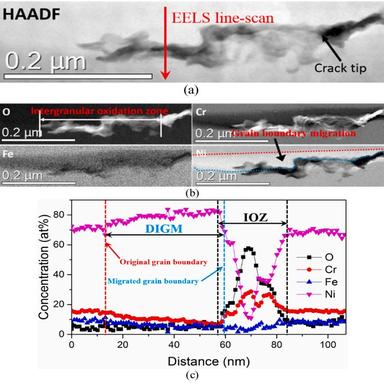
(a) HAADF image showing the morphology around a representative crack tip prepared from Fe-16Cr-75Ni alloy tested at 360 ◦C; (b) EELS elemental O K edge and Cr/Fe/Ni L edge maps; (c) EELS quantitative composition line profiles across the IOZ and DIGM zone.